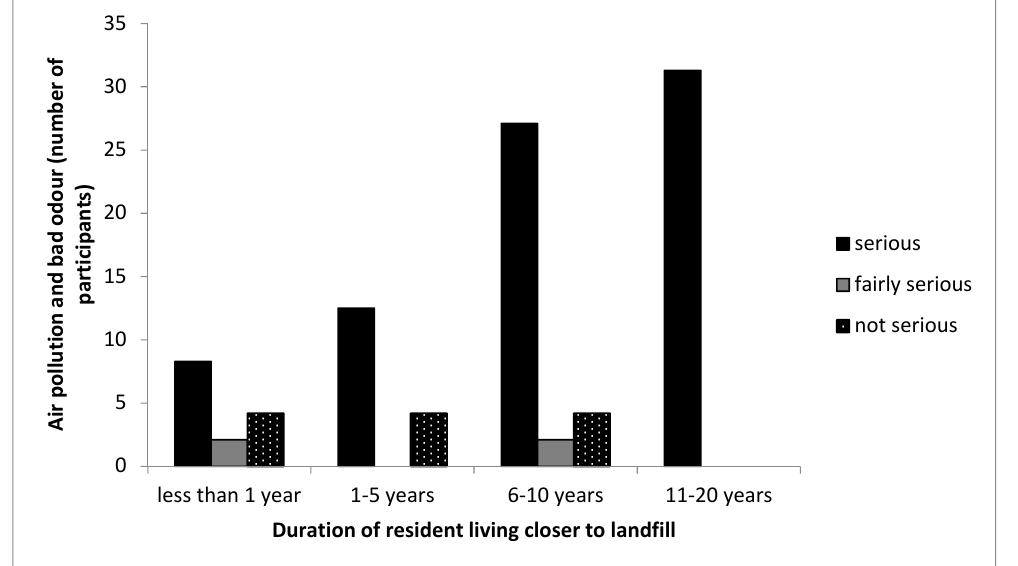
Figure 5. Cross-tabulation between the duration participants lived in the CL community and the seriousness of air pollution and bad odour. Note that the no bar section in the figure indicates there was no response by the participant.